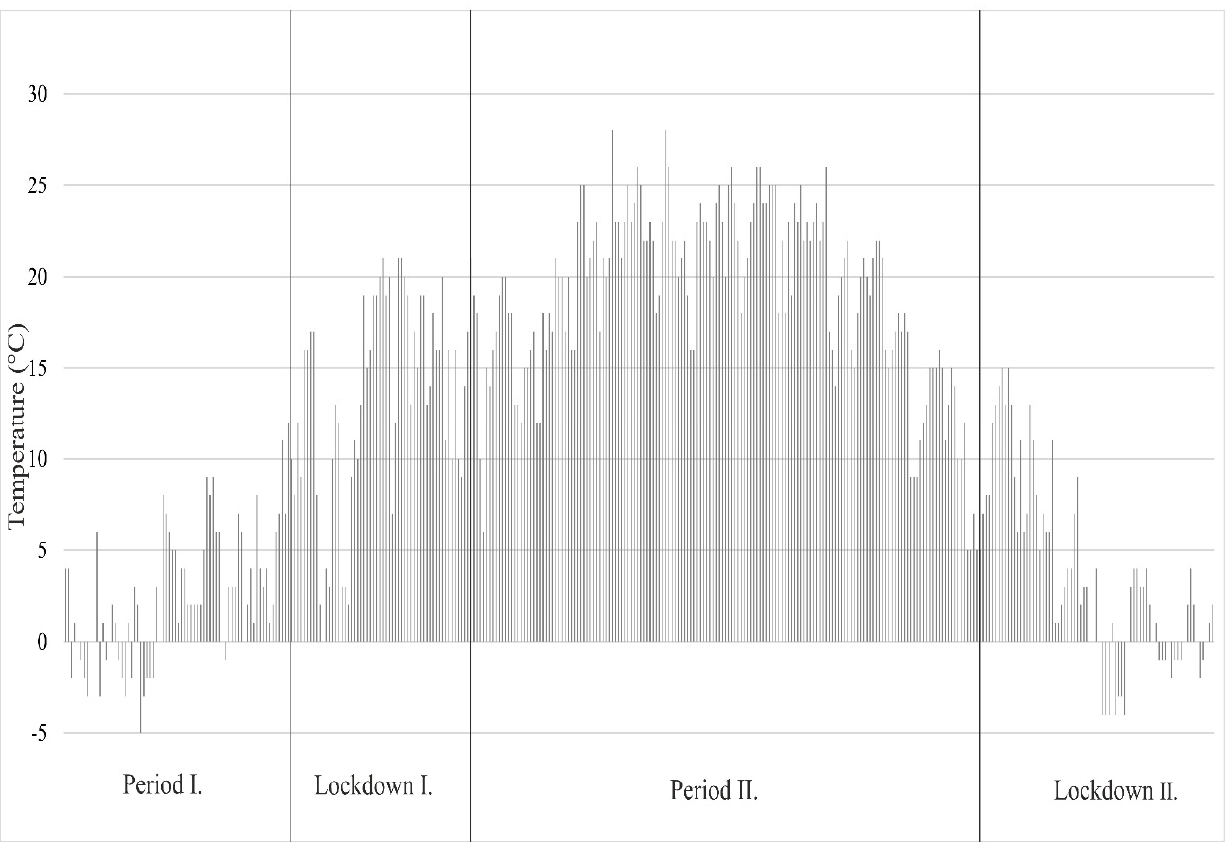
Figure 2. Daily air temperature in the individual periods of the year 2020in USFE Zvolen [30].